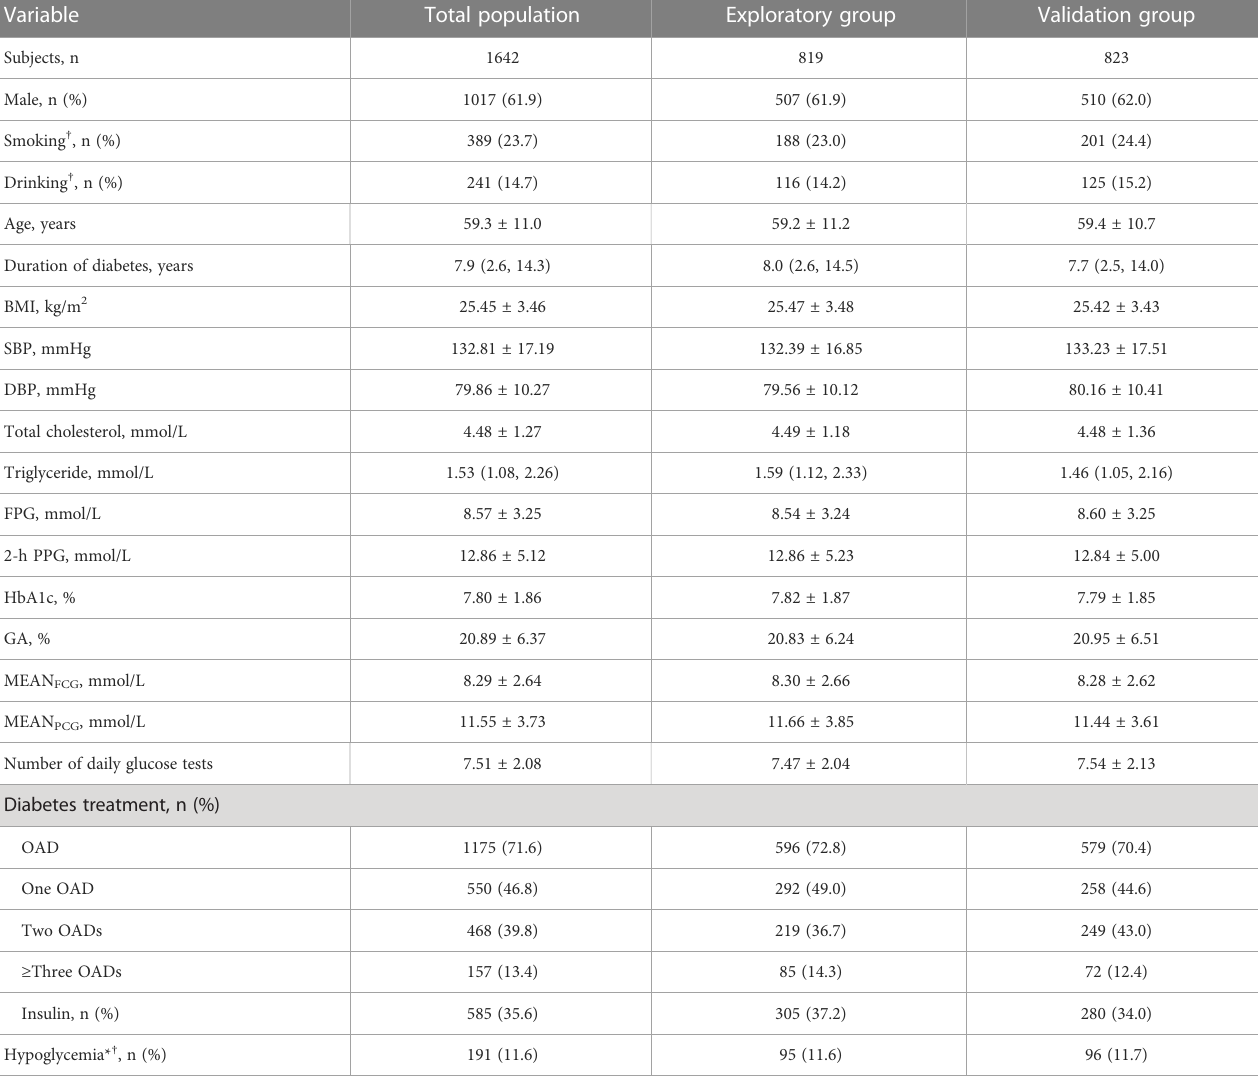
TABLE 1 Characteristics of 1642 patients with type 2